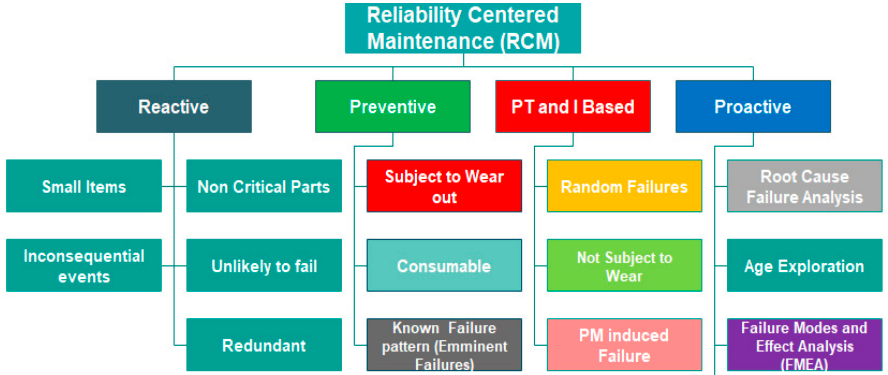
Figure 4. Components of a reliability-centered maintenance (RCM) program.